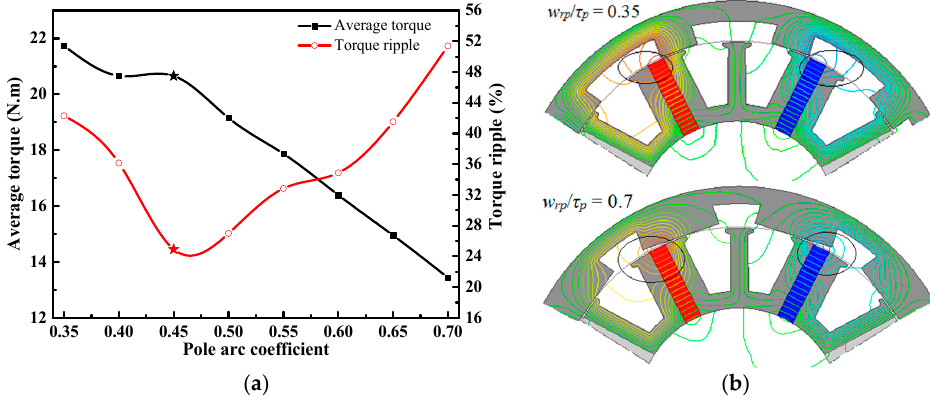
Figure 10. Average torque, torque ripple and flux leakage of magnet outer radius: ( a ) Average torque and torque ripple with increasing rotor pole arc coefficient; ( b ) the flux leakage of magnet outer radius in module M A .